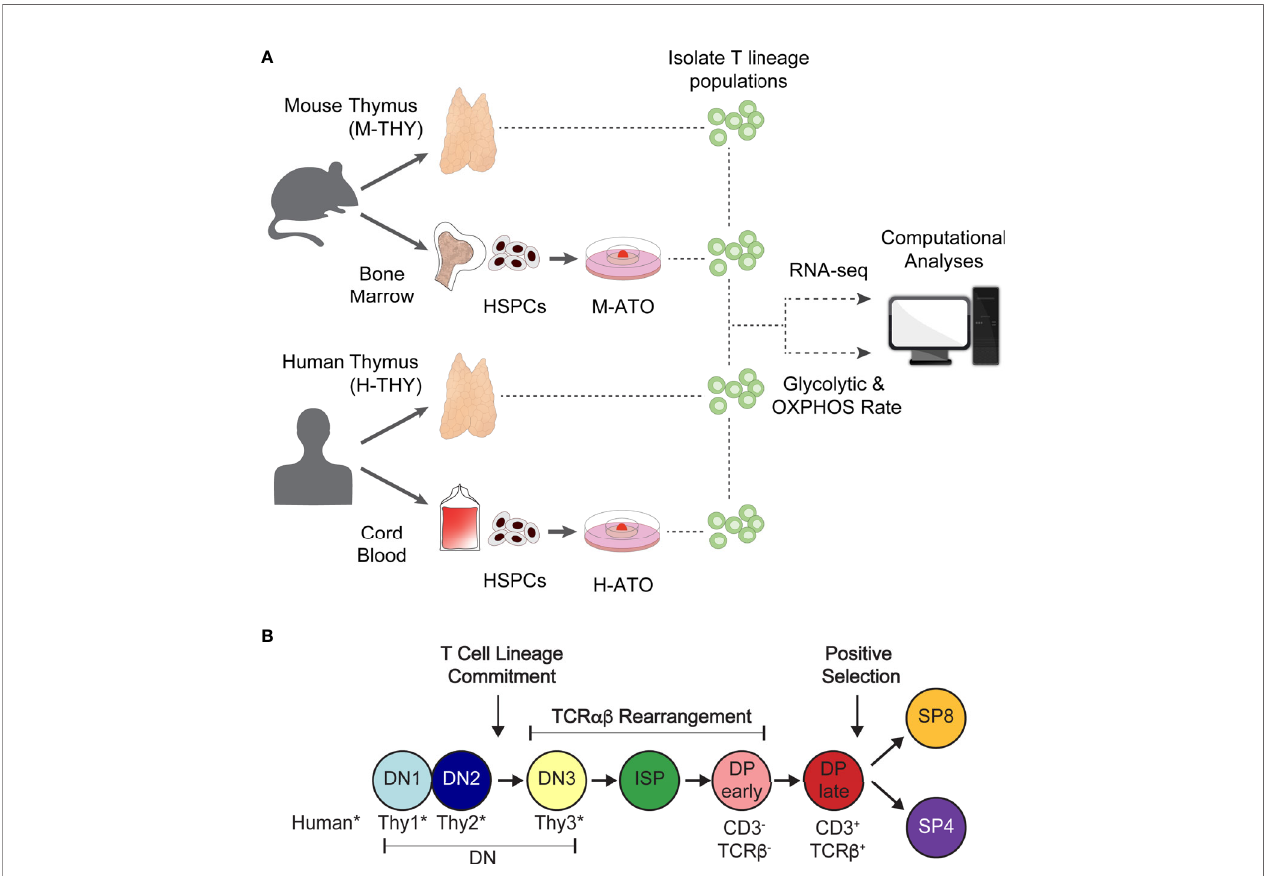
( Supplementary Table 2 ) for further analyses as: fold-change greater than 2, Benjamini-Hochberg adjusted Wald test p -value less than 0.01 in at least one pair-wise test, and a minimum expression of 5 FPKMs in at least one sample; genes with less than half-count per million in all samples, count outliers, or low mappability (<50bp) were fi ltered out from the differential gene expression analysis (12, 27, 32). This set of most signi fi cantly variable genes was subjected to model-based clustering using MBCluster.Seq (33) to classify them based on their overall abundance pro fi le across populations ( Figure 1B ). We set the starting number of clusters to 100, and then manually merged them to generate a set of 16 non-redundant gene classes. Functional enrichment for genes selected in the tests and clusters above was performed with Metascape (34). All heatmap visualizations were created using pheatmap R package, and all line plots were created using spline function and ggplot2 package in R.